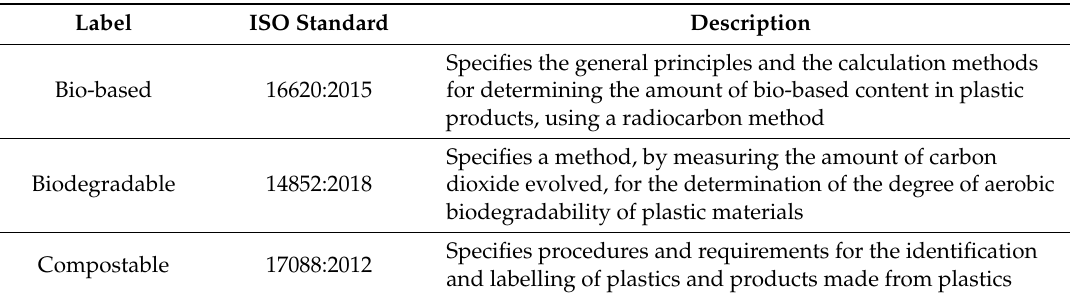
Table 1. International Organization for Standardization (ISO): bio-based, biodegradable and compostable standards. Adapted from: [17,22 – 24].